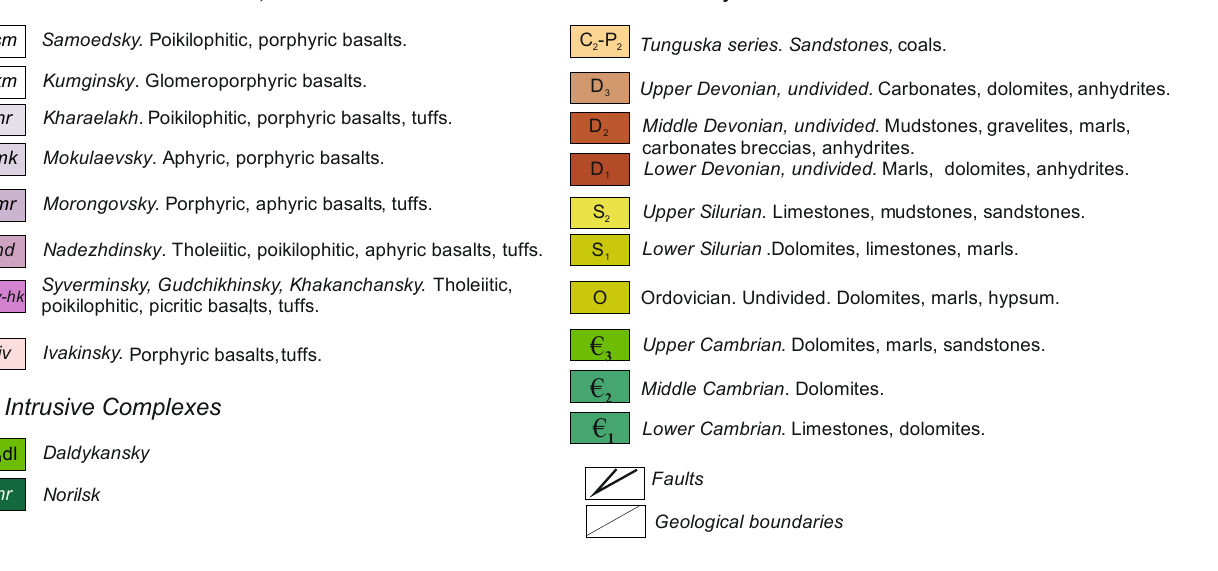
Figure 2. Geological map and cross-sections of the studied area.